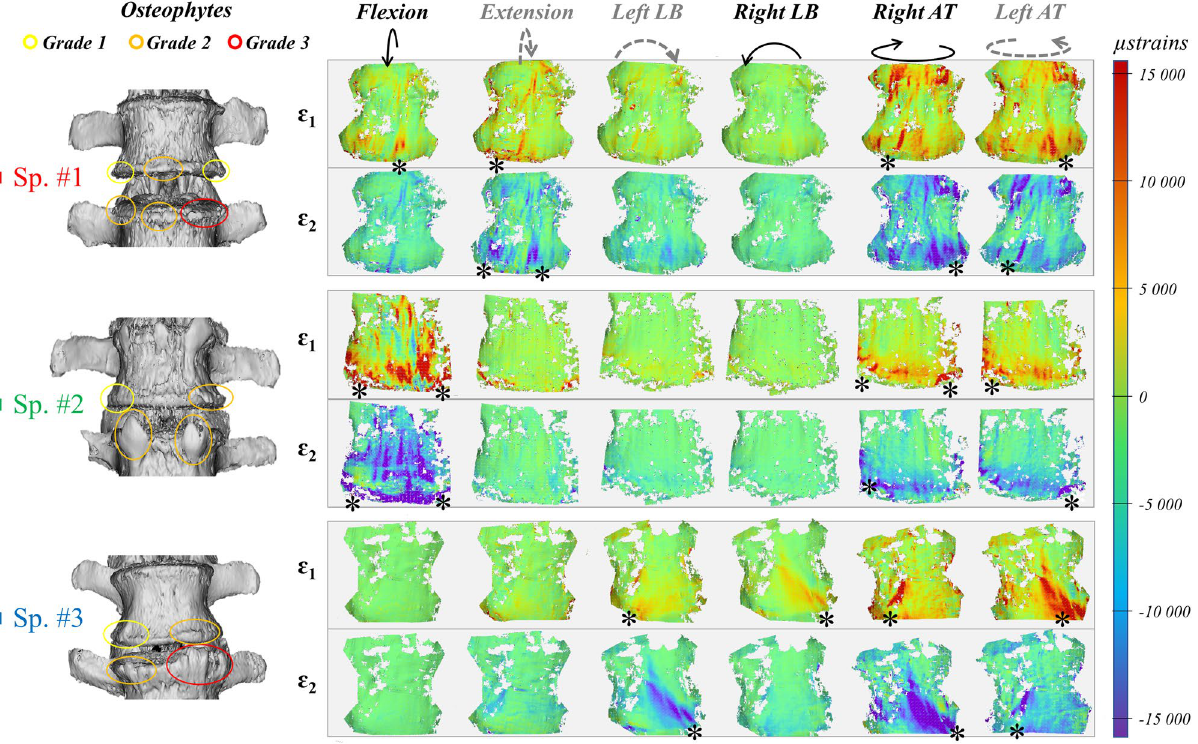
Figure 9. Specimen-specific analysis of maximum (ε 1 ) and minimum (ε 2 ) strain maps vs. osteophyte grade for cases “PSO-2” at full load for all loading conditions. CT reconstruction of each specimen (left) was used to grade osteophytes formations 26 . The asterisks (*) indicate the presence of strain intensification effects. The DIC strain maps have been obtained using the proprietary software Istra 4D (v4.3.1, Dantec Dynamics, Denmark; URL: https ://www.dante cdyna